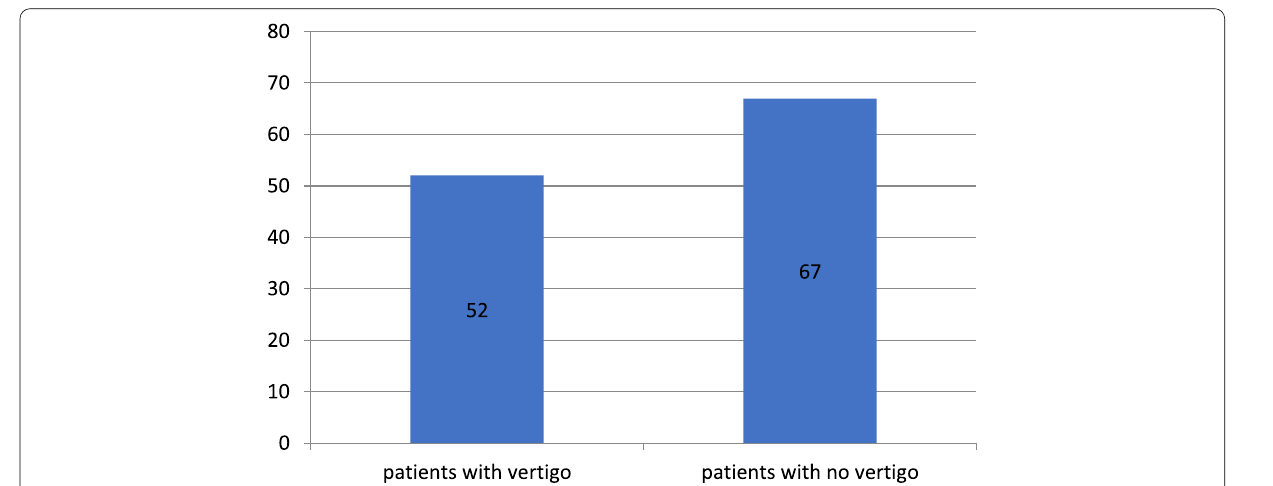
Fig. 2 Vestibular complaint among COVID‑19 patients